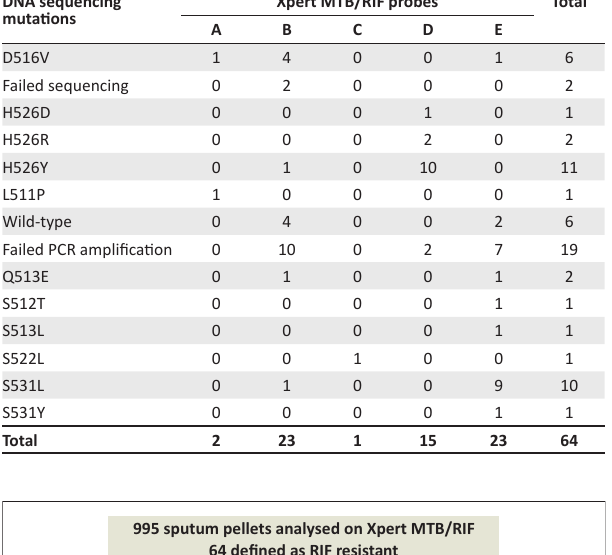
TABLE 1: rpo B gene mutations associated with Xpert MTB/RIF probes used. DNA sequencing mutations